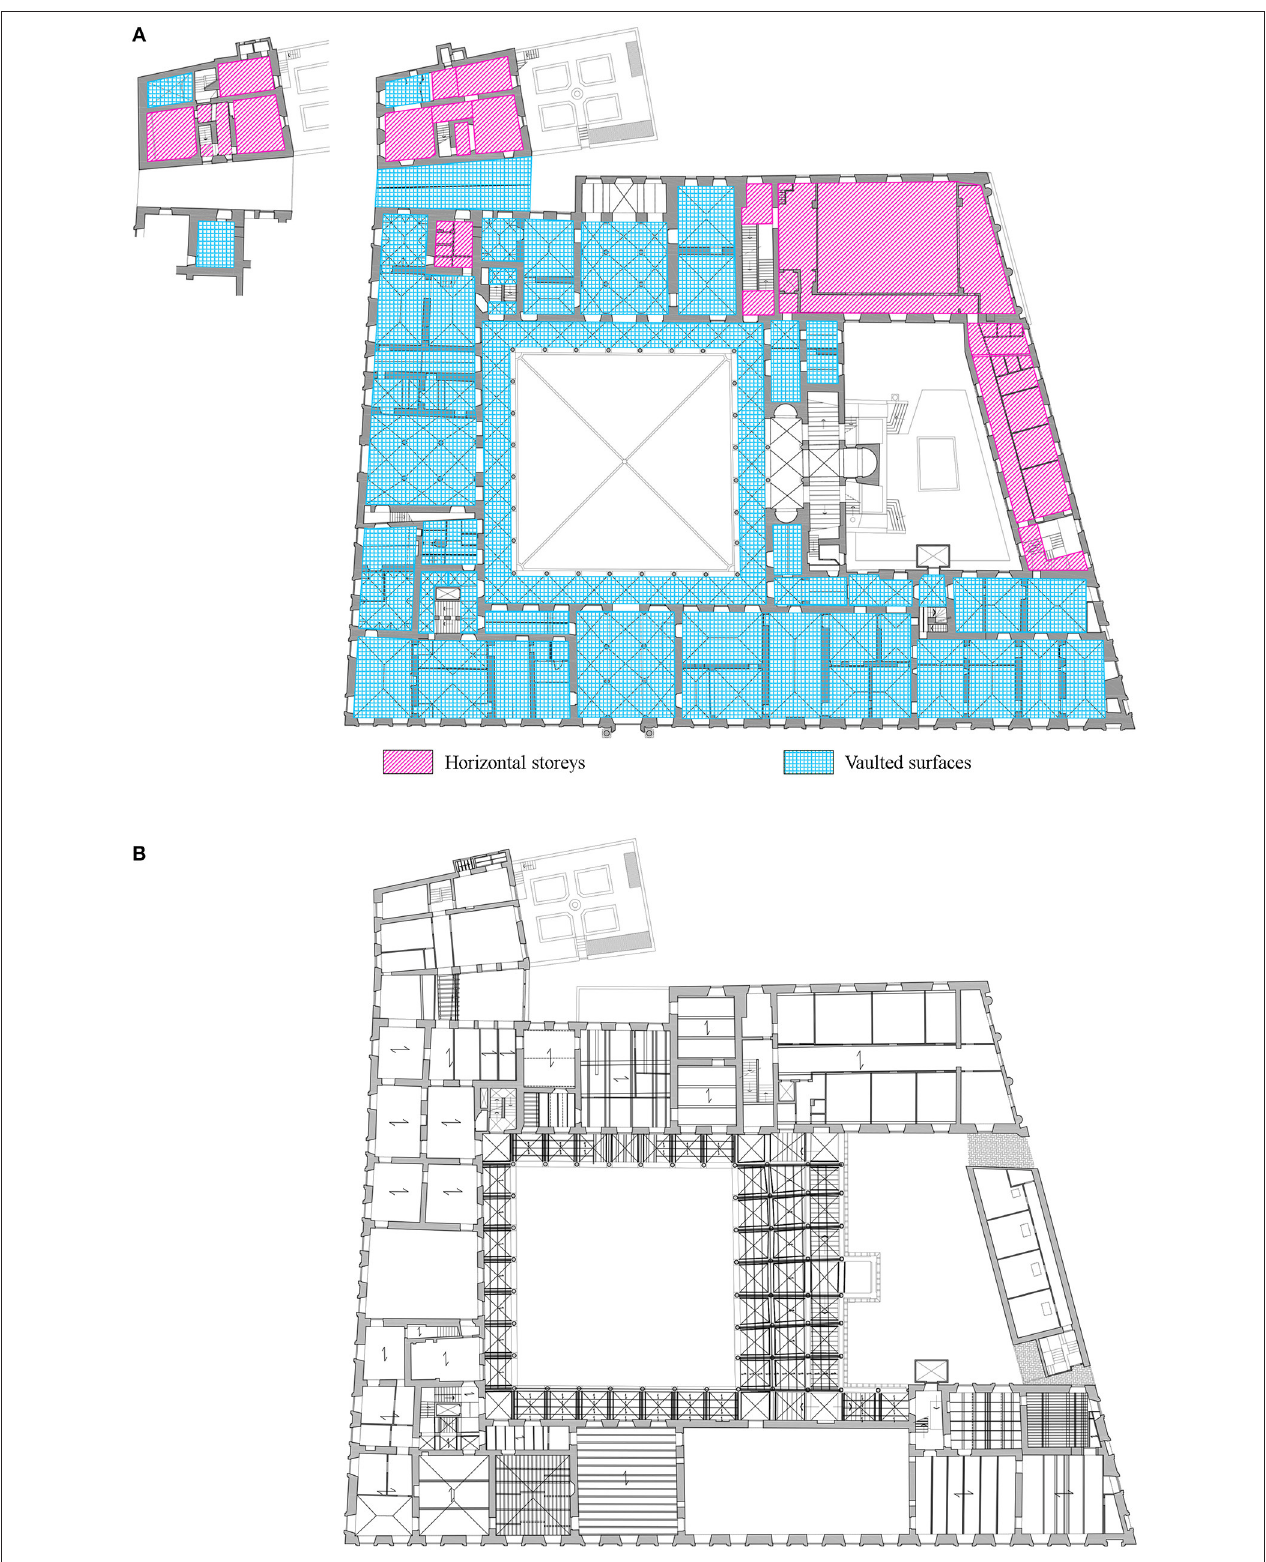
FIGURE 11 | (A) Floor typologies (flat or vaulted) surveyed in correspondence to the second level of Palazzo Ducale. (B) Floor typologies surveyed in correspondence to the third level of Palazzo Ducale.